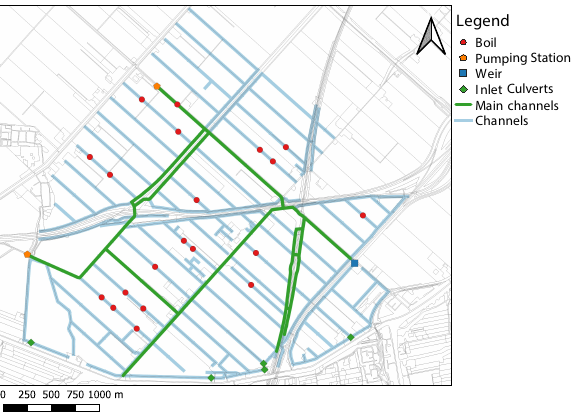
Figure 2. The layout of the Lissertocht catchment showing the structures, main channels and boil